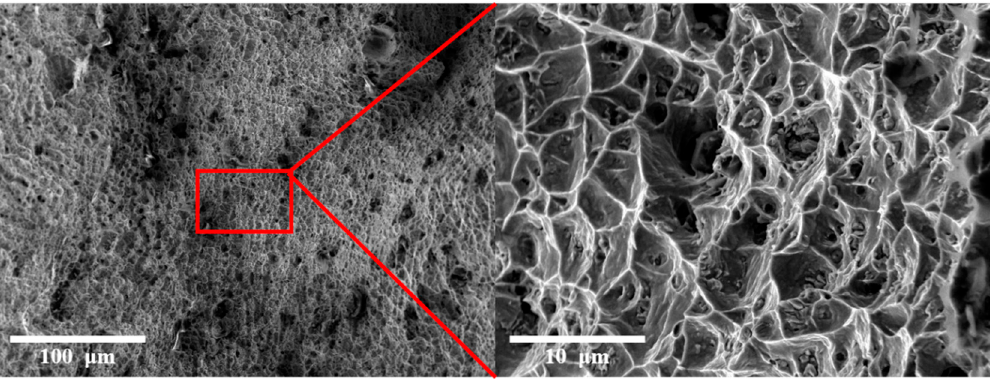
Figure 9 . Microscopic appearance of fracture.